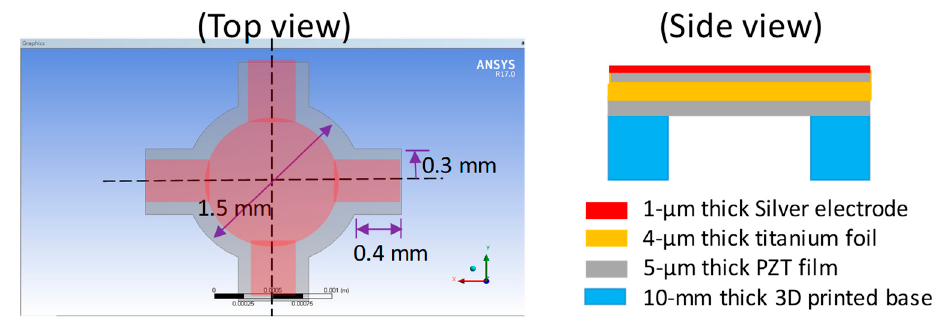
Figure 1. The designed structure of the PMUT vibrational portion ( left ) and the related structural parameters ( right ).